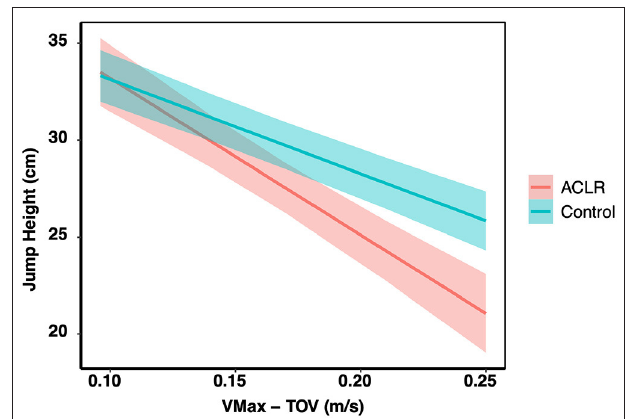
FIGURE 6 | Relationship between group status (anterior cruciate ligament reconstructed–ACLR, non-injured control–Control), Vmax-TOV– 1 maximum velocity of the body center of mass and takeoff velocity and vertical jump height. A significant group x Vmax-TOV was found ( p < 0.01). For every 0.1 m/s increase in the Vmax-TOV, jump height was decreased by 9.3cm for the ACLR group and 4.9cm for the Control